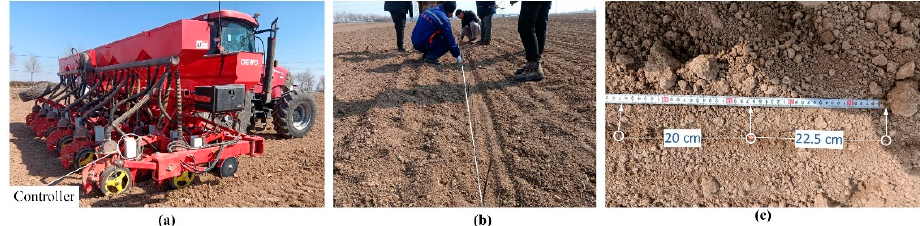
Figure 13. Precision electric seeder and monitoring system test. ( a ) Eighteen-row maize precision electric seeder and monitoring system; ( b ) label seed position; ( c ) seed spacing measurement. According to GB/T 6973-2005, the qualified index, QI, reseed index, RI, missing index, MI, and coefficient of variation, CV, were calculated as evaluation indices of sowing quality.